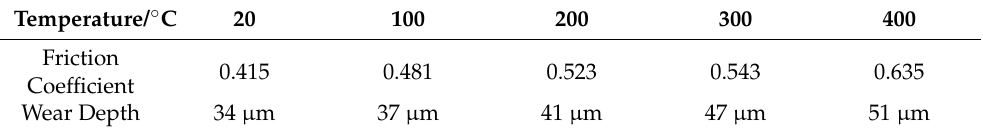
Figure 2. Friction coefficient and wear depth of stainless-steel wire at different temperatures vary with time in group 1: ( a ) friction coefficient; ( b ) wear depth.